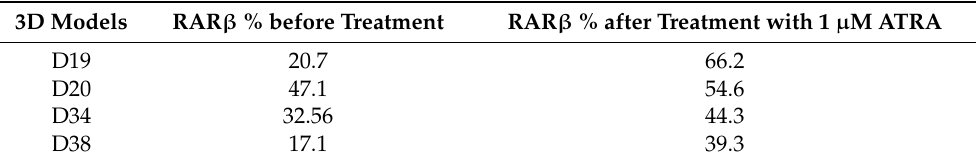
Table 3. RAR β expression in 3D-tissue-engineered oral mucosa models before and after treatment with 1 µ M